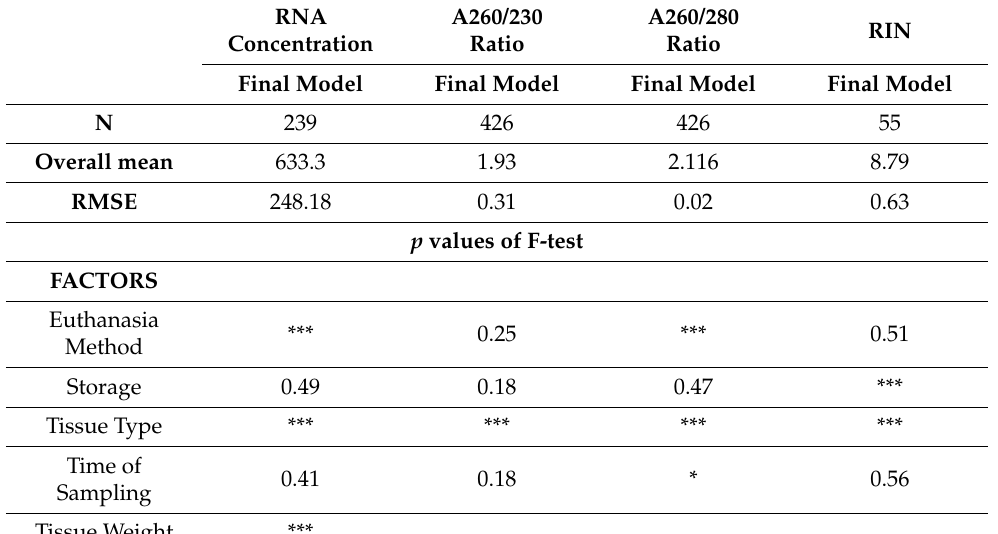
Table 2. Modelling results for RNA concentration, A260/230 ratio, A260/280 ratio and RIN value as dependent variables: F-test, ls-means and estimates obtained in a linear